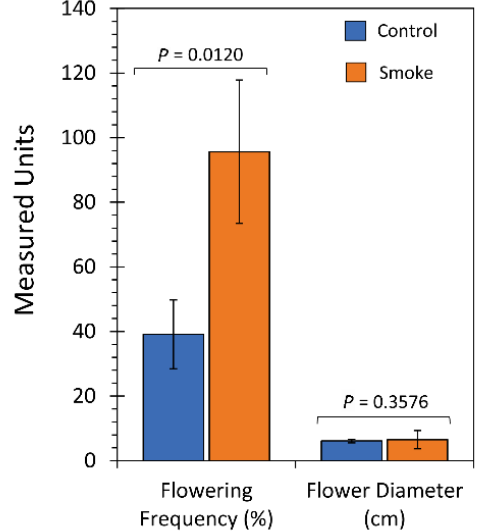
Figure 9. Flowering metrics. The relative flowering frequency was measured at 72 days after sow ‐ ing. This metric accounted for multiple flowers on individual plants. Flower diameter, measured in centimeters (cm), represented the diameter of the disk floret. Data bars represent average values ± SE for control, N = 22 plants and liquid smoke ‐ treated, N = 23 plants. p ‐ values < 0.05 were considered statistically significant. statistically